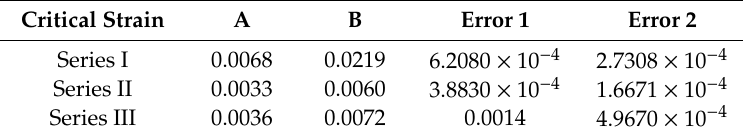
Figure 11. Relationship between the critical strain and the strain rate of concrete under different SF levels. Table 8. The estimated results for di ff erent concrete in Equation